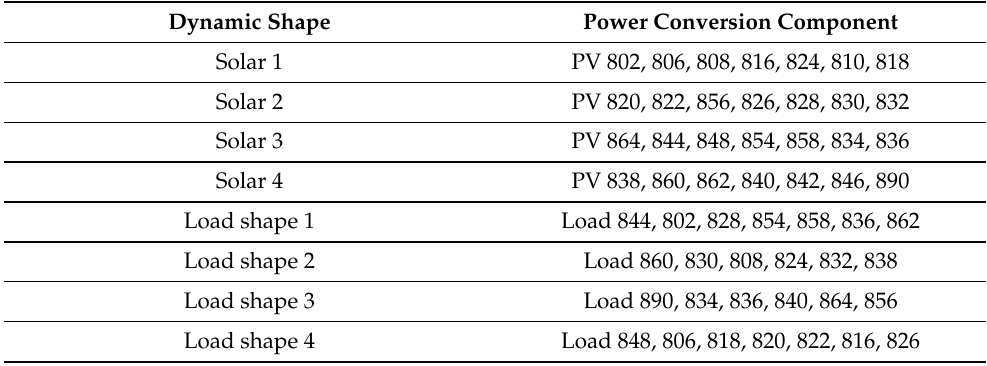
Table A1. Assignment of different loadshapes to power conversion components in the case study. These time variant loadshapes are the source for dynamics.